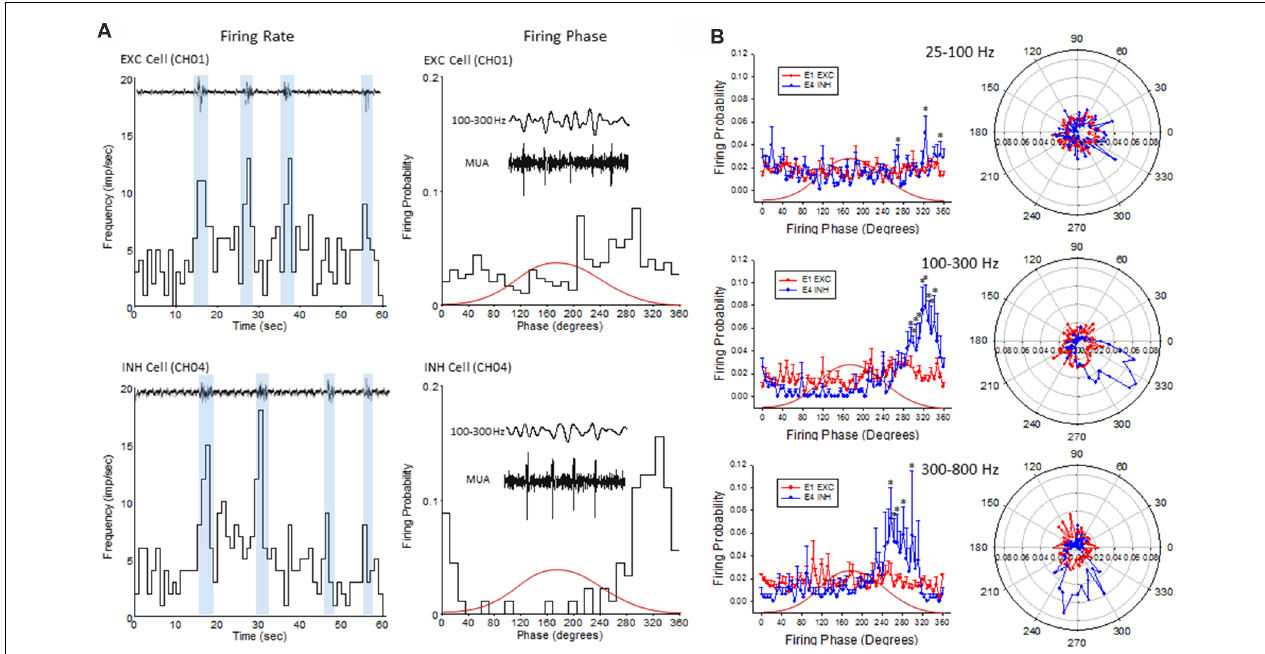
FIGURE 9 | Firing phase analysis between EXC units recorded from channel 1 (CH01) and INH units recorded from (CH04) across HFO bandwidths. (A) Firing rate (left column) of exemplar EXC (top) and INH (bottom) single-units in comparison to B-S activity. Blue bars indicate the increase in firing rate during B-S events. Firing phase (right column) of these same units in relation to HFOs (100–300 Hz). (B) Average firing phase (left column) of EXC (CH01, n = 5) and INH (CH04, n = 4) units across three frequency distributions. ∗ P < 0.05 between groups (Holm-Sidak post hoc analysis). The same data is presented in polar plots (right column) to demonstrate the relative phase-locking of average unit activity across each frequency spectrum. Red curves in (A,B) indicate the relative phase of the associated